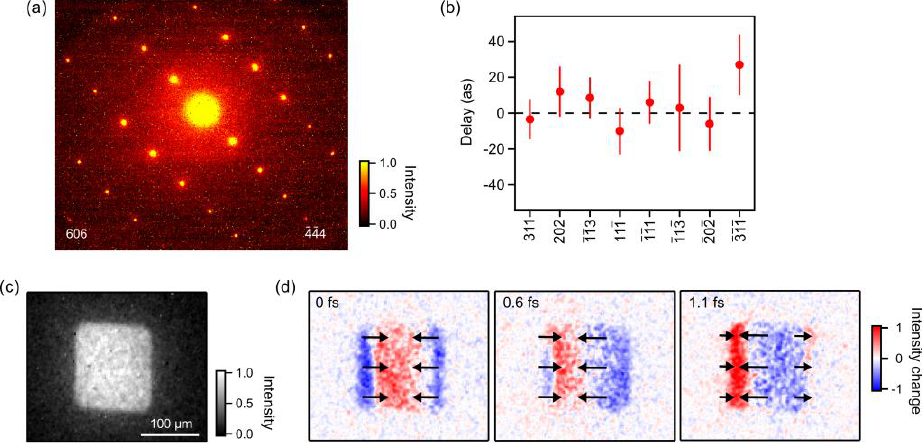
Fig. 2. Attosecond electron diffraction and microscopy. (a) Bragg diffraction of a single-crystal silicon membrane measured with attosecond electron pulses. (b) Attosecond delay of Bragg spots with respect to the direct beam. (c) Microscopic shadow image of the silicon sample. (d) Delay- dependent image changes. Black arrows represent direction of streaking